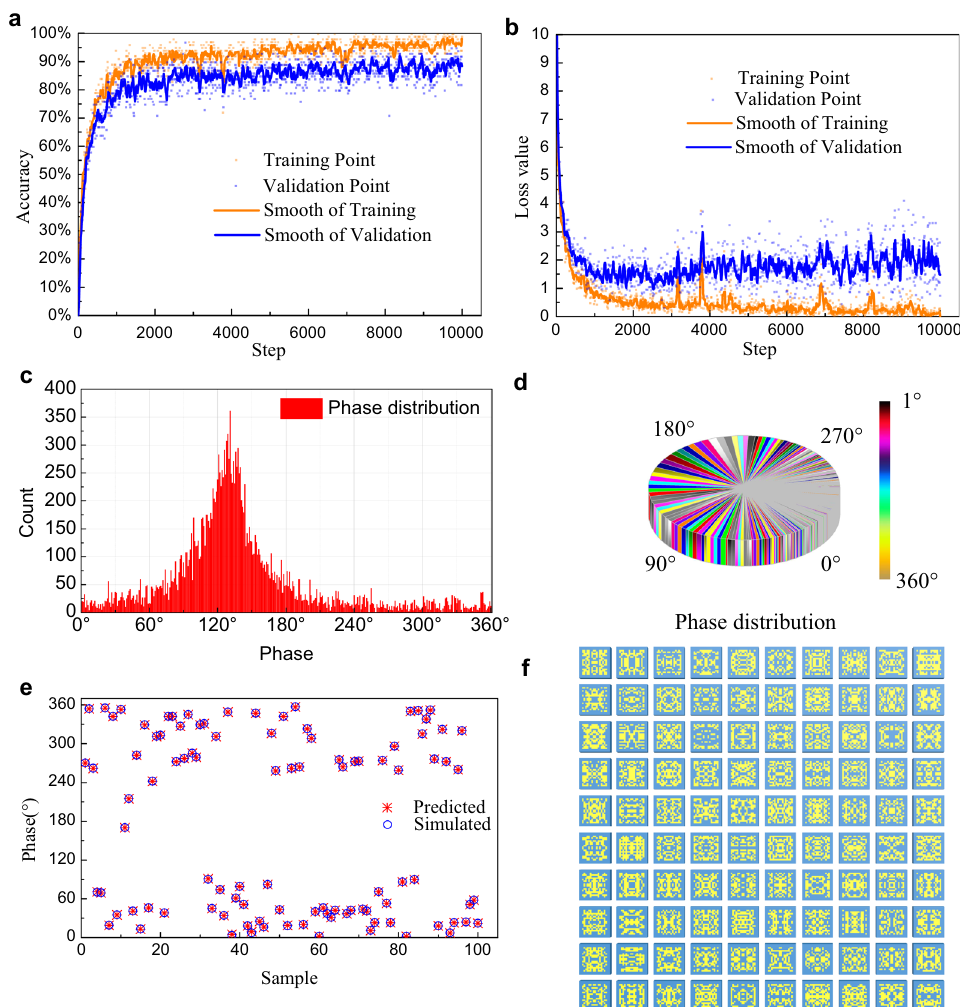
Fig. 3 The results about TLN model. a The accuracy of training process. b The value of loss function. c Histogram of phase distribution of dataset. d The pie chart of phase distribution of dataset. e The random 100 samples and their predicted/simulated phases. f The 100 meta-atom patterns corresponding to the 100 phase samples, which are generated by the trained transfer learning model and can achieve the simulated phases.